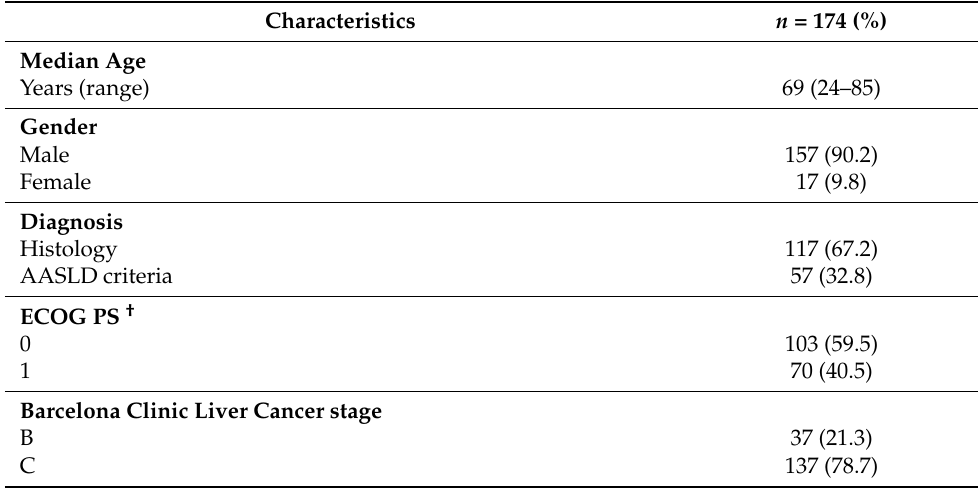
Table 1. Patient demographics and baseline